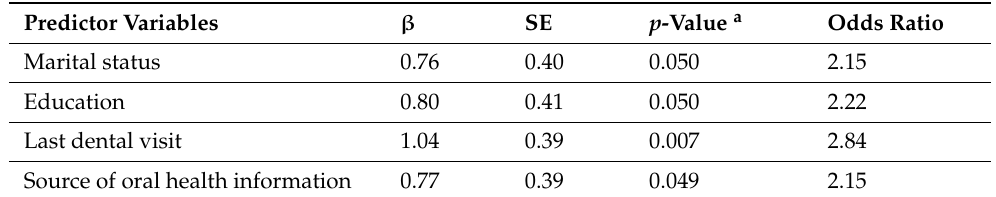
Table 5. Multivariate analysis between toothbrushing frequency at least twice a day and independent variables.